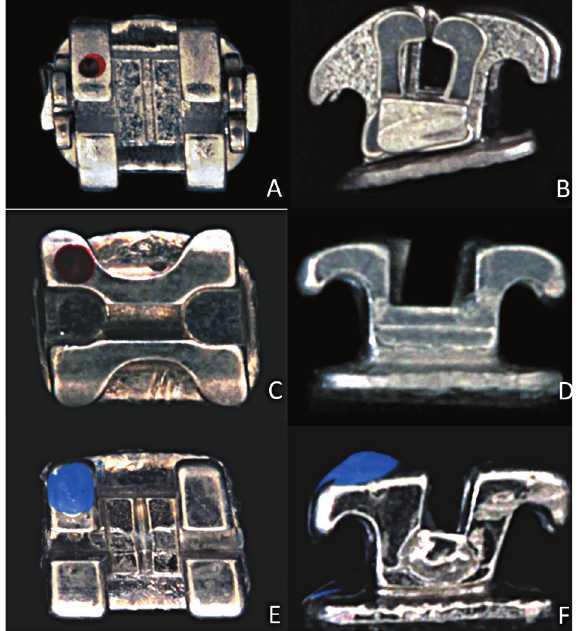
Figure 1- Brackets evaluated. (A-B) Passive self-ligating bracket. (C-D) Bracket with modified slot design. (E-F) Conventional